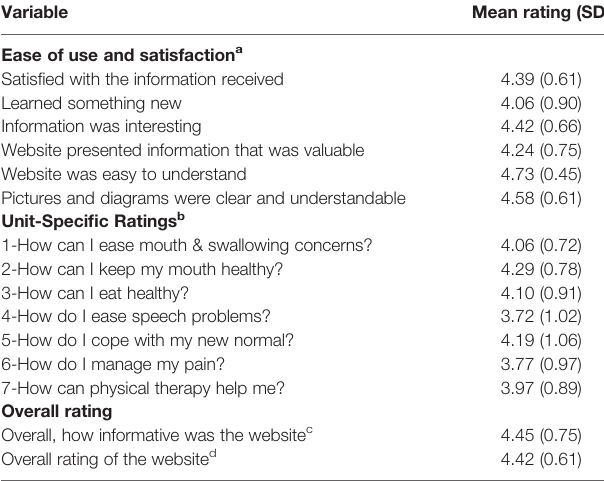
TABLE 3 | Participant